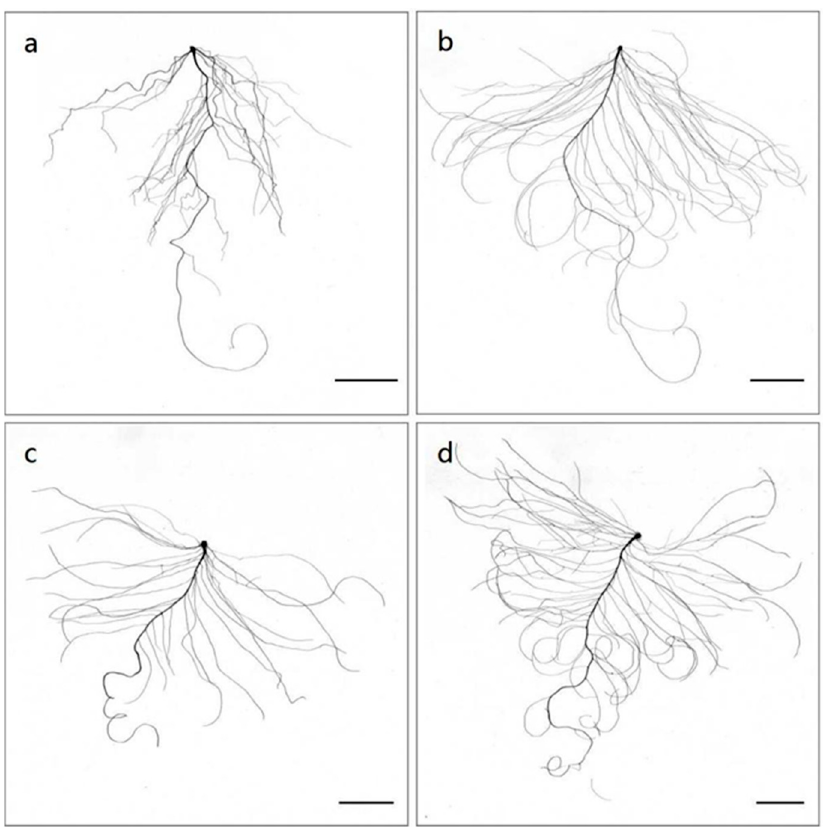
Figure 2. Roots of L14 and L40 under different N supply conditions. ( a ) L14 under CK; ( b ) L14 under LN; ( c ) L40 under CK; ( d ) L40 under LN. Bar = 2 cm. Table 1. Shoot and root phenotypes of L14 and L40 under different N supply conditions.